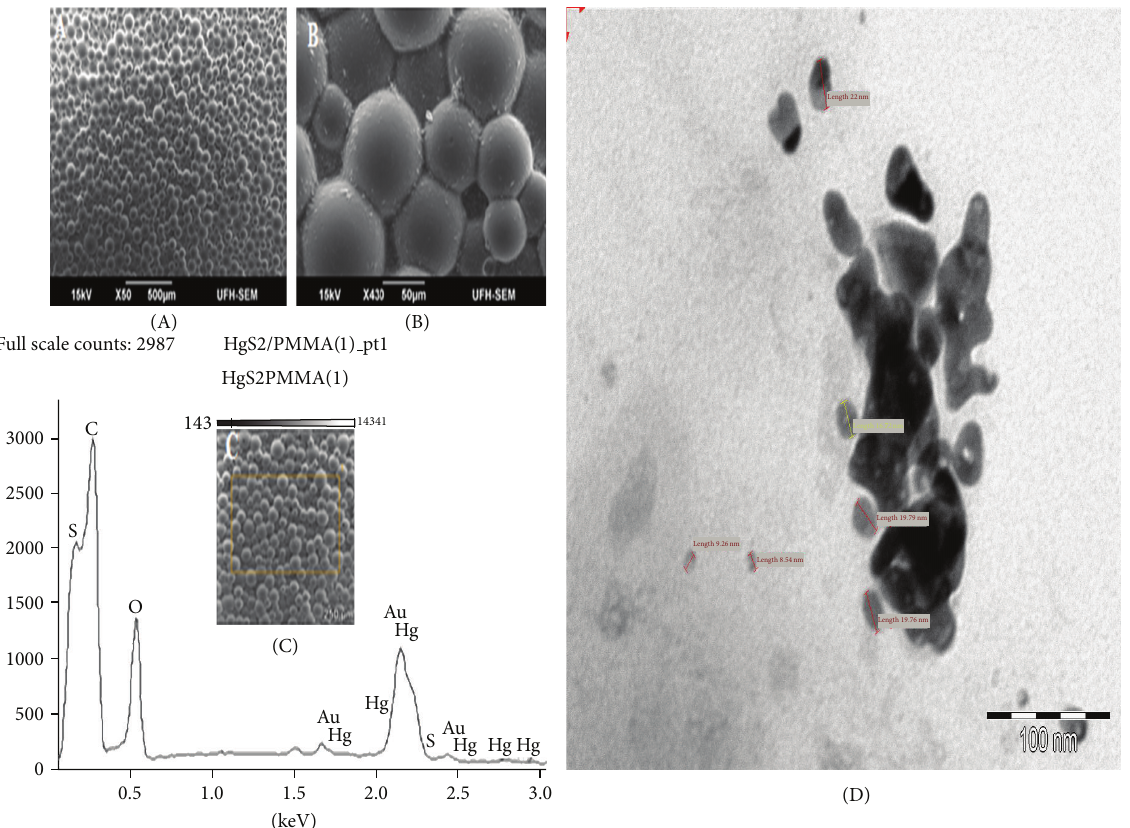
Figure 6: (A) and (B) are SEM micrograph of HgS2/PMMA nanocomposites. (C) EDX spectrum; (D) TEM